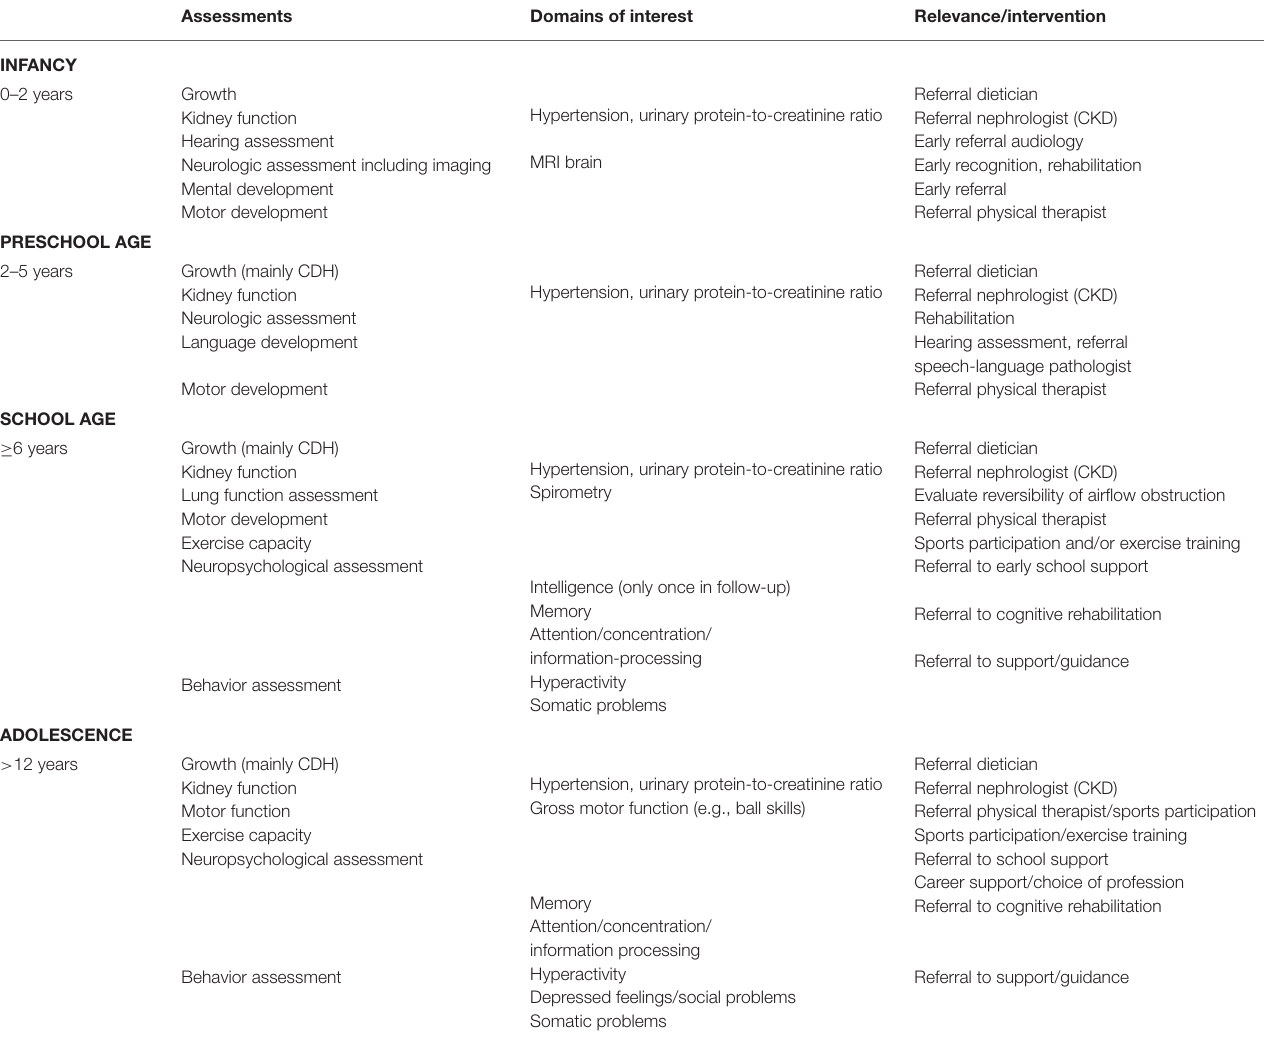
TABLE 1 | Proposal for and relevance of long-term follow-up after (neonatal)